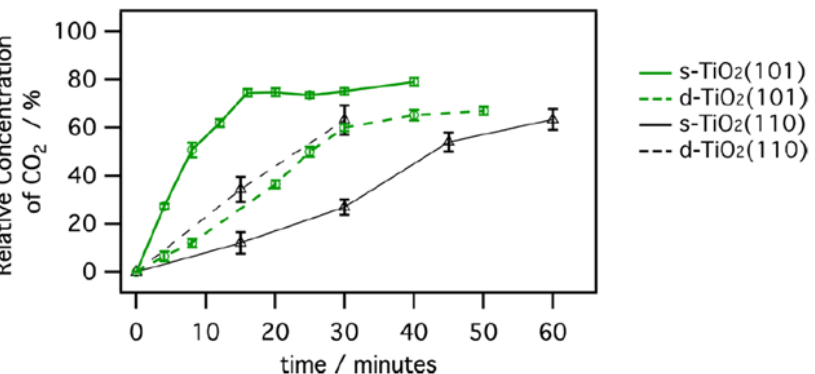
Figure 10. Photocatalytic oxidation of CO on anatase (green) and rutile (black). The graphs for the reduced surface are shown by dotted lines, whereas the graphs for the stoichiometric surface are indicated as solid lines. Reprinted with permission from [122]. Copyright 2020, American Chemical Society.